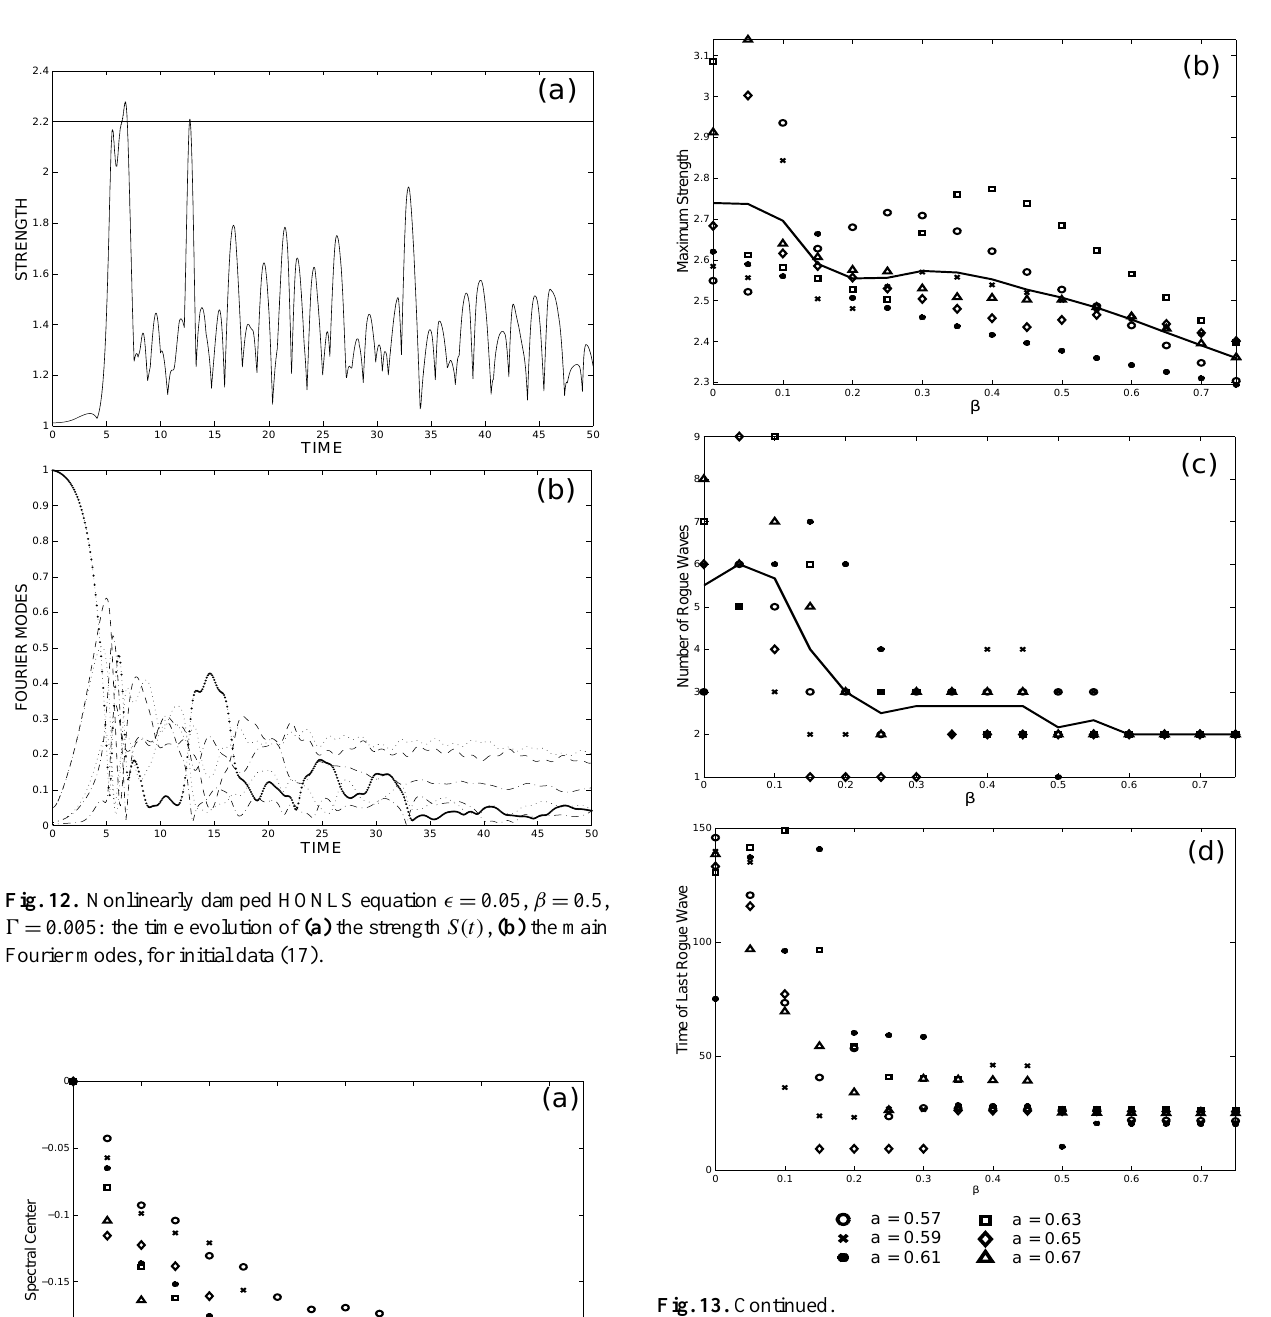
0 0.1 Fig. 13. The HONLS equation with nonlinear damping 0 < β < k m at t = 200, (b) max t ∈[ 0 , 200 ] S(t) , (c) number of rogue waves, and (d) time of last rogue wave as a function of β . The solid curves represent the averages.